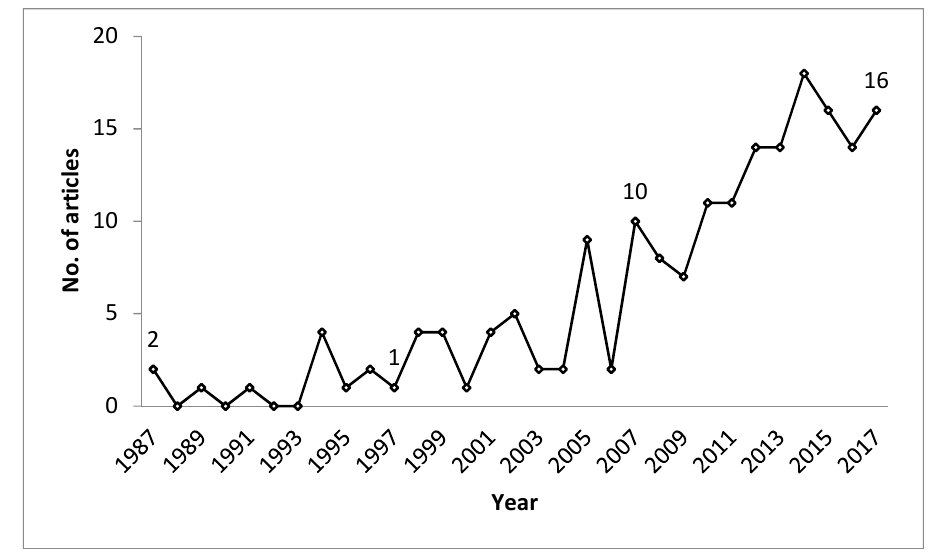
Figure 1. Proportion of articles from journals of different disciplines contributing to the literature on WEFs (wild edible fruits), in percentages ( n = 185).